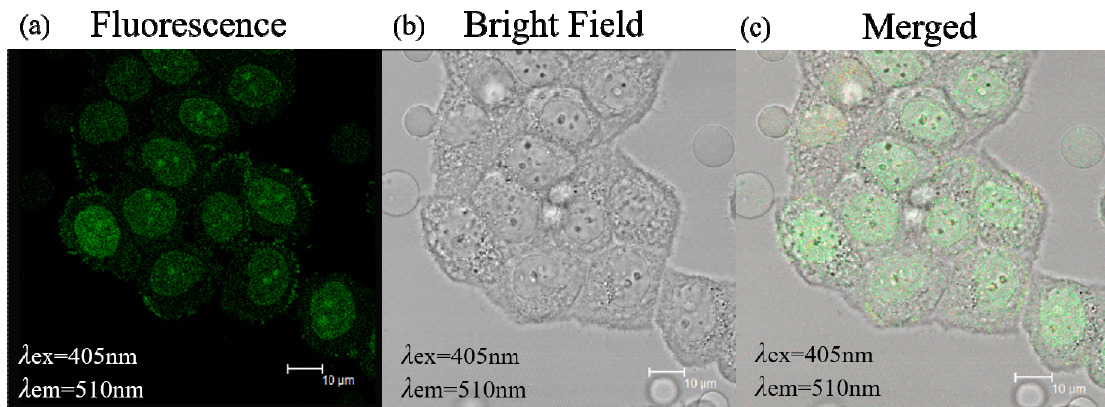
Figure8. ( a )FluorescencemicroscopeimageofC / N-dotsandthecorrespondingbrightfieldtransmission Figure 8. ( a ) Fluorescence microscope image of C/N-dots and the corresponding bright field image ( b ) and merged image ( c ) of Hela-229 transmission image ( b ) and merged image ( c ) of Hela-229 cells.